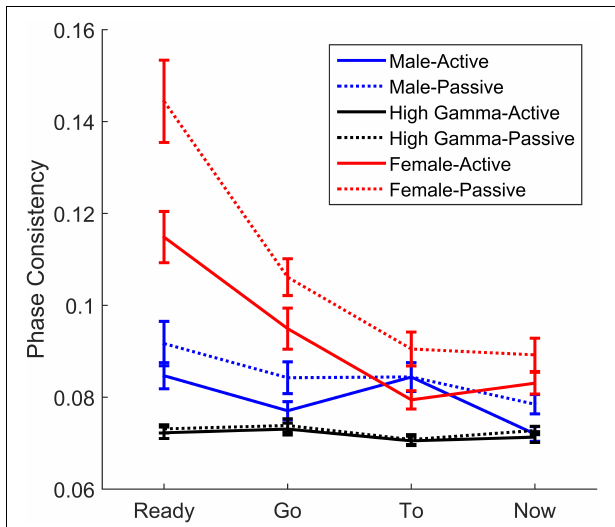
FIGURE 8 | Comparisons of high gamma, male and female pitch contours across words and listening condition. While cortical high gamma phase consistency did not differ between conditions, both the subcortical phase consistency in response to the male and female pitch contours decreased during active